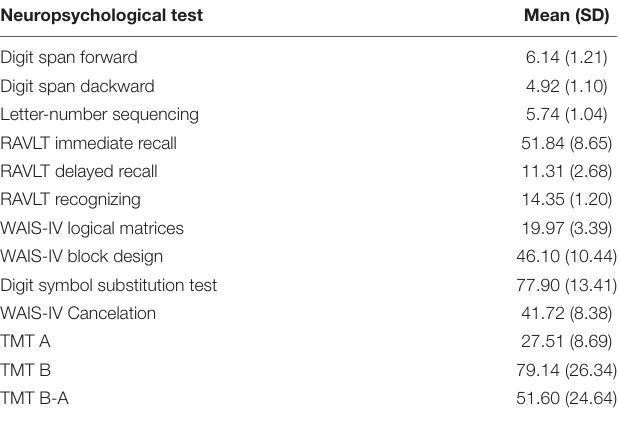
TABLE 2 | Results of formal neuropsychological testing of participants. Neuropsychological test